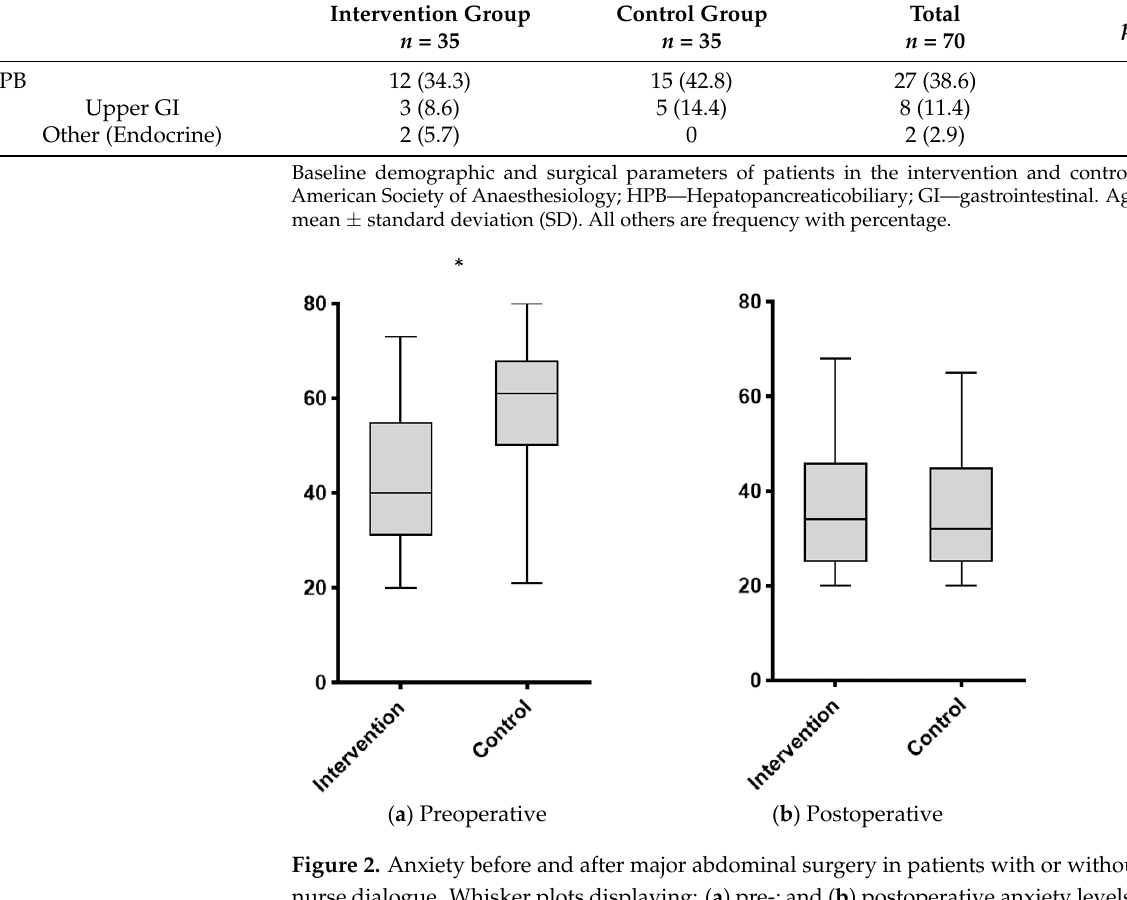
( b ) PONV Figure 3. Postoperative pain and nausea: ( a ) Evolution of postoperative pain scores over time. Dis- played are mean scores (dots) with S.E.M.; VAS—visual analog scale (0–10), POD—postoperative day S.E.M.—standard error of the mean; ( b ) Percentage of patients presenting with postoperative nausea in patients in the intervention group (black bars) and patients in the control group (white bars). PONV—postoperative nausea and vomiting, POD—postoperative day.